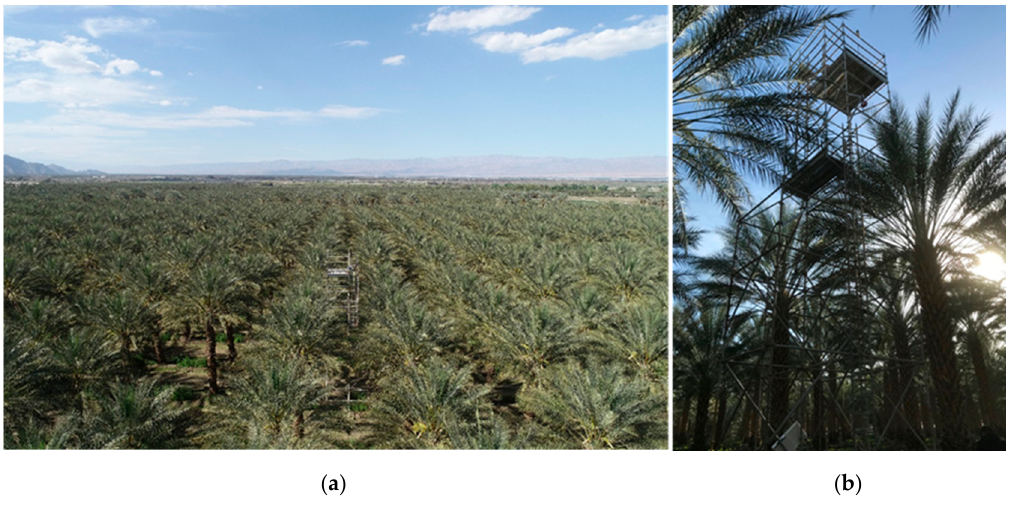
Figure 1. ( a ) Flux tower set up at the DP3 experimental site located in Thermal, California, and ( b ) an aerial view of the tower from a distance and the right picture demonstrates a ground view of the tower.